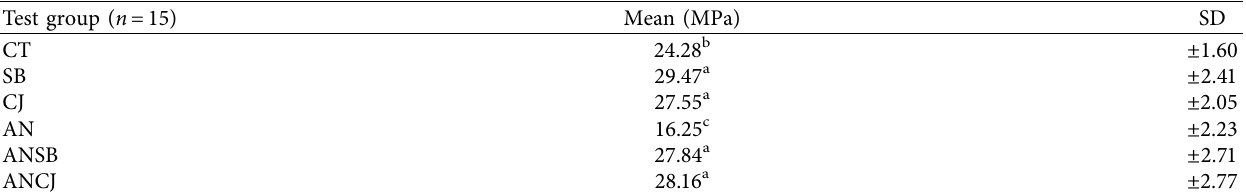
ANCJ 28.16 a ± 2.77 The same superscript letter indicates no statistically significant difference between the groups ( p < 0 .